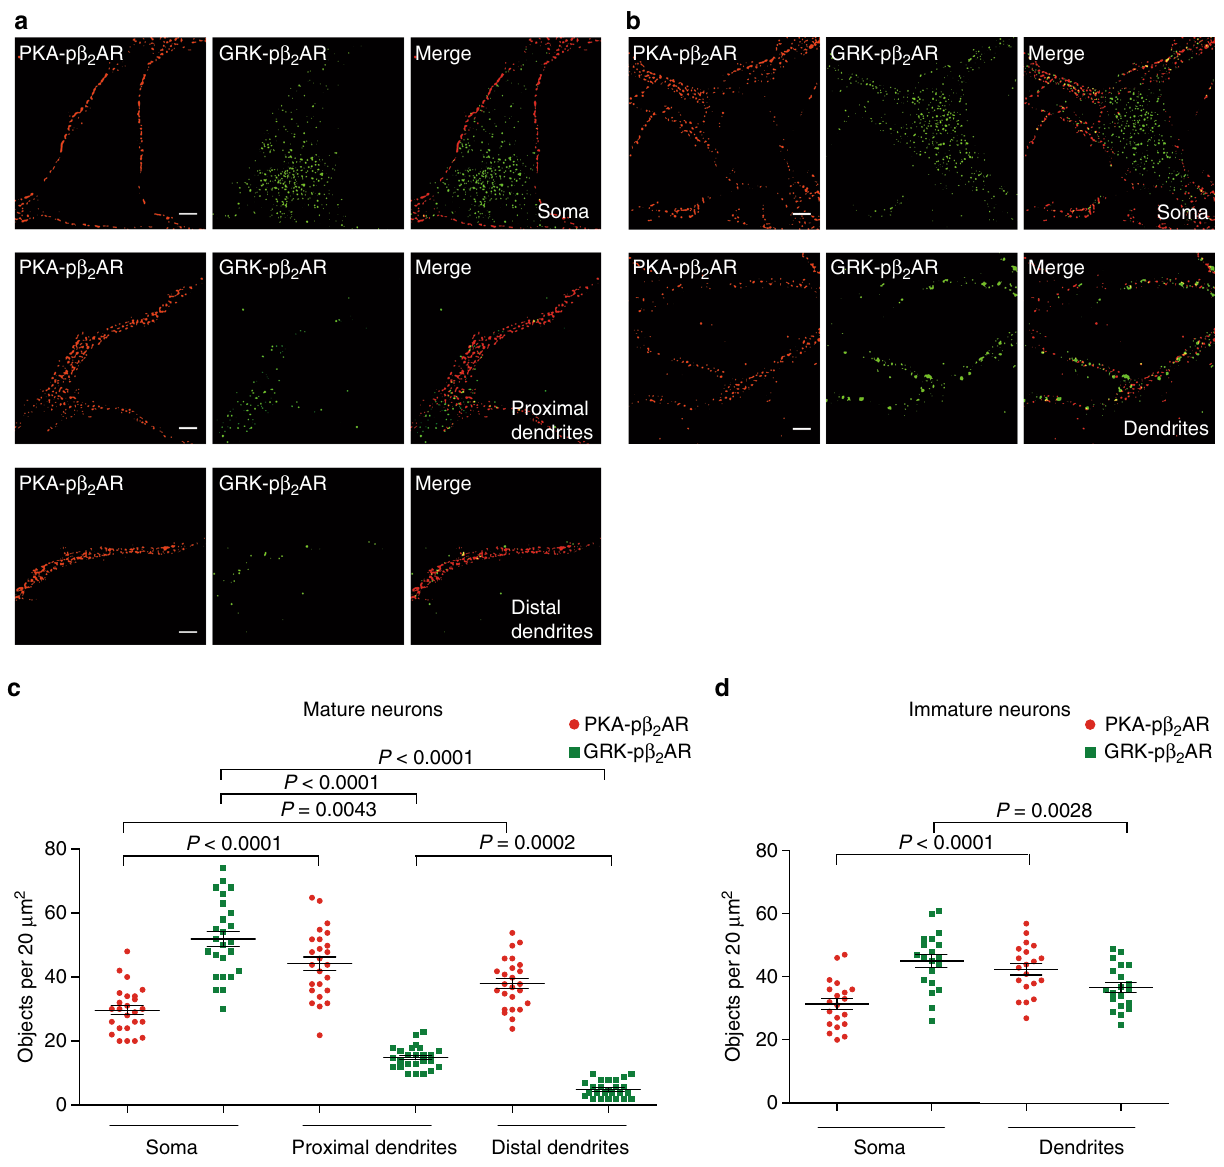
Fig. 5 Subpopulations of β 2 AR are spatially segregated between dendrites and soma in hippocampal neurons. Primary hippocampal neurons expressing FLAG- β 2 AR at 18 – 21 days in vitro (DIV, mature, a ) or 6 – 8 DIV (immature, b ) were treated with 1 μ M ISO for 5 min ( a ) or 10 min ( b ). Neurons were stained with phospho-speci fi c antibodies against S261/262 (PKA-p β 2 AR) and S355/356 (GRK-p β 2 AR) as indicated to show phosphorylated β 2 ARs in soma, and proximal and distal dendrites (Scale bar, 2 μ m. n = 25 and 20 cells, respectively, three independent experiments). Representative SIM images in a and b were from one single neuron. c Numbers of fl uorescent objects per 20 μ m 2 regions were quanti fi ed with ImageJ in 18 – 21 DIV mature neurons (PKA-p β 2 AR, soma 29.6 ± 1.7, proximal dendrites 42.6 ± 2.2, and distal dendrites 38.6 ± 1.8; GRK-p β 2 AR, soma 50.4 ± 2.7, proximal dendrites 14.9 ± 0.7, and distal dendrites 5.1 ± 0.6). d Numbers of fl uorescent objects per 20 μ m 2 regions were quanti fi ed with ImageJ in 6 – 8 DIV immature neurons (PKA-p β 2 AR, soma 31.4 ± 1.7 and dendrites 42.6 ± 1.8; GRK-p β 2 AR, soma 45.1 ± 2.0, and dendrites 36.8 ± 1.5). Error bars denote s.e.m., multiplicity adjusted P values are computed by one-way ANOVA followed by Tukey ’ s test between indicated